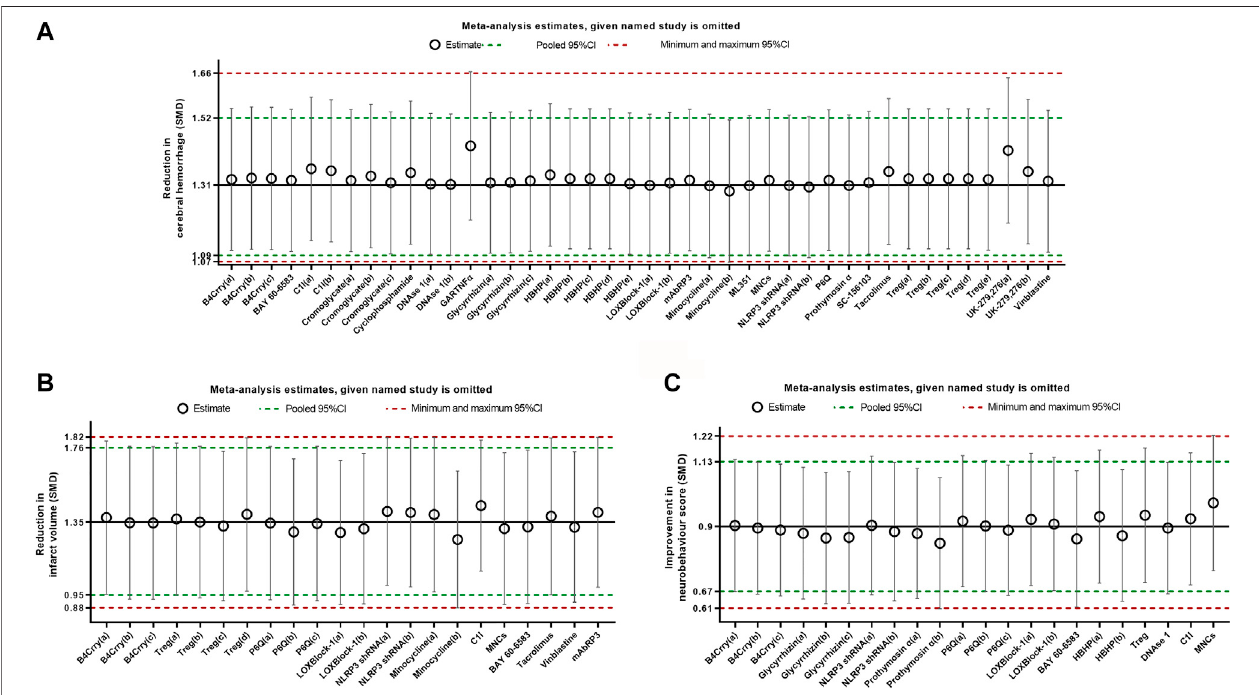
FIGURE7| Sensitivityanalysisforintracerebralhemorrhage (A) ,infarctsize (B) ,andneurobehavioralscore (C) evaluatingtherobustnessoftheresults.Thevertical error bars represent the 95% con fi dence interval for the individual estimates. The horizontal red bars represent the potentially minimum and maximum 95% con fi dence interval and the horizontal green bars represent the actual 95% con fi dence interval of the pooled estimate of ef fi cacy.